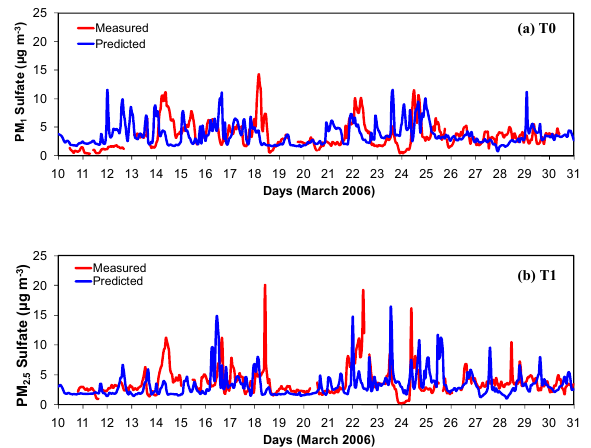
Figure 5: Comparison of model hourly predictions against measurements for PM 1 sulfate taken Fig. 5. Comparison of model hourly predictions against measure- at T0 (a) and PM 2.5 sulfate taken at T1 (b), during the MILAGRO campaign. ments for PM 1 sulfate taken at T0 (a) and PM 2 . 5 sulfate taken at T1 (b) , during the MILAGRO campaign.